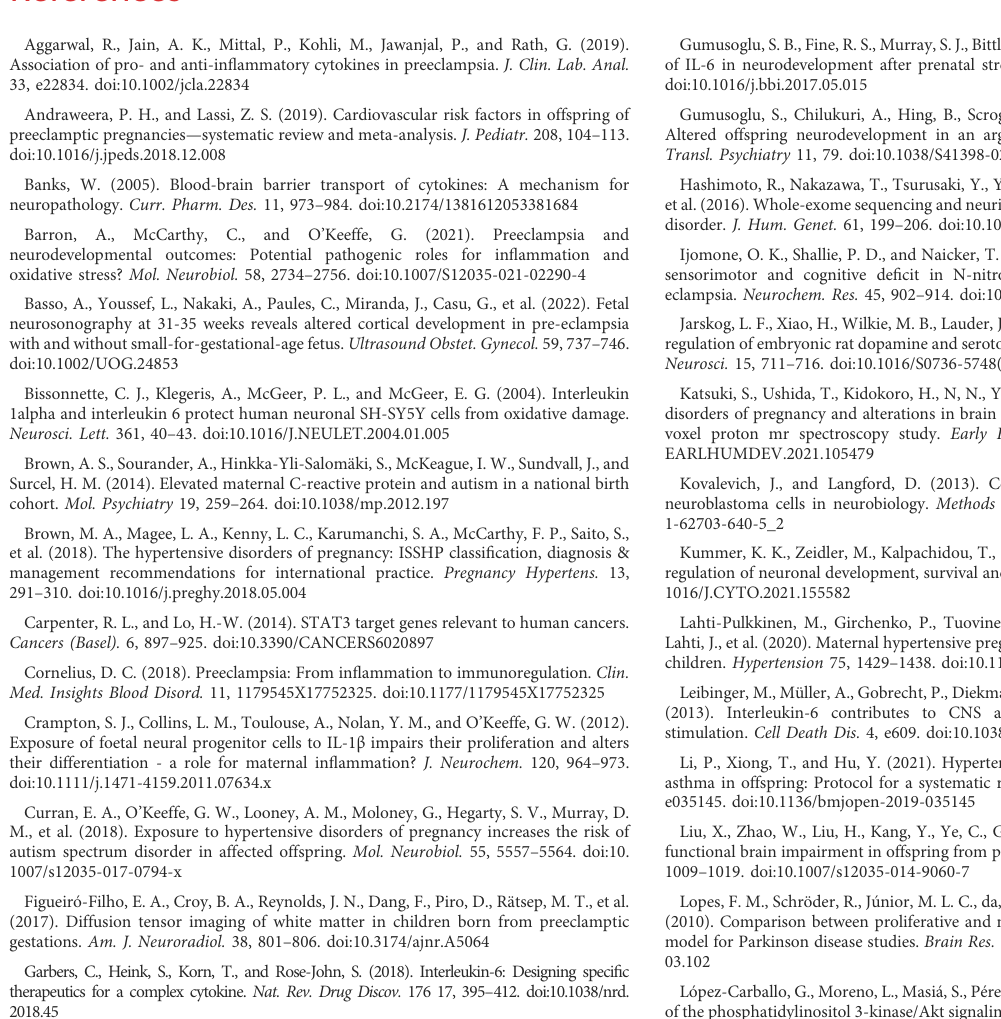
SUPPLEMENTARY FIGURE S2 Pre-eclampsia serum does not affect mitochondrial superoxide, biomass or membrane potential in differentiated SH-SY5Y Cells. RA-differentiated SH- SY5Y cells were treated with 3% (v/v) serum from pre-eclamptic patients (PE) or normotensive pregnant controls for 72 h Mean fl uorescence intensity of (A)